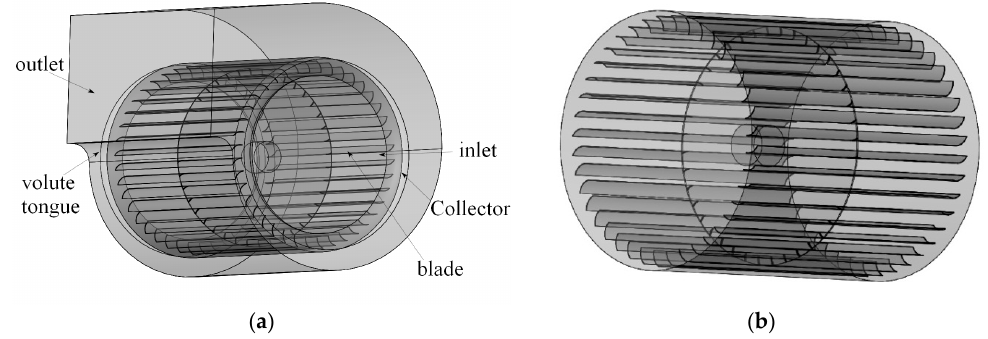
Figure 1. Three-dimensional model of the baseline centrifugal fan: ( a ) whole fan; ( b ) impeller. Table 1. Specifications for the centrifugal fan.